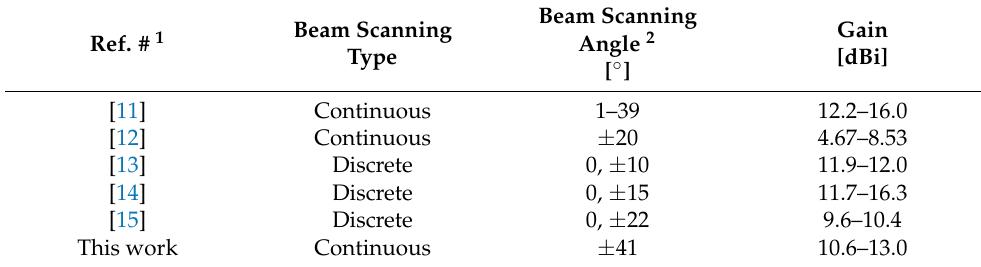
Table 3. Performance comparison of beam-steering FPC antennas.